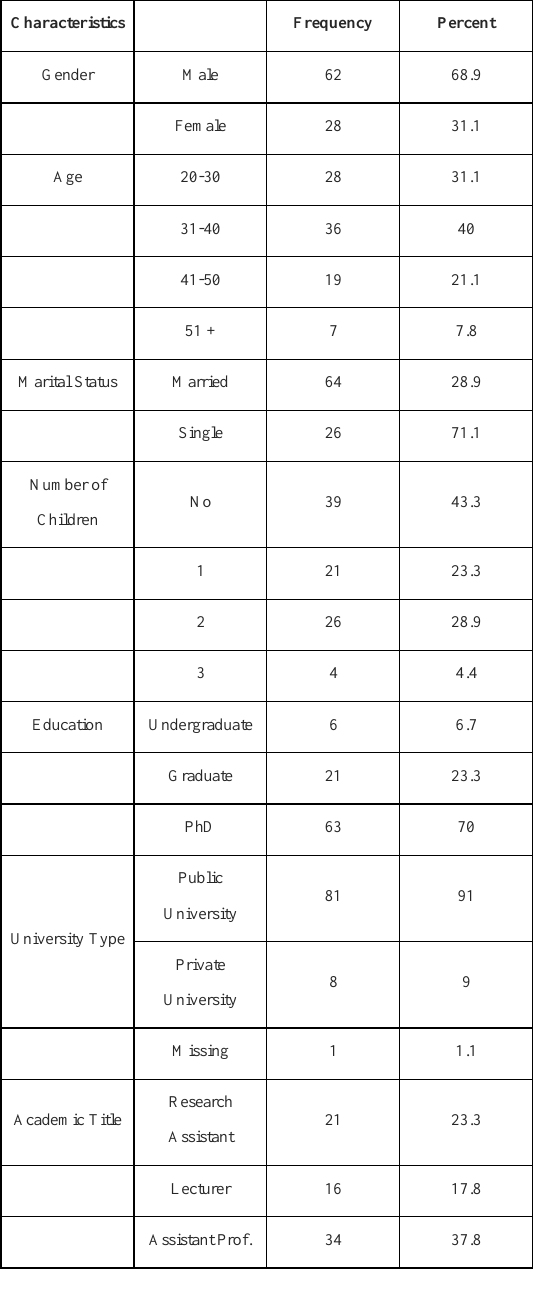
Table I. Characteristics of the